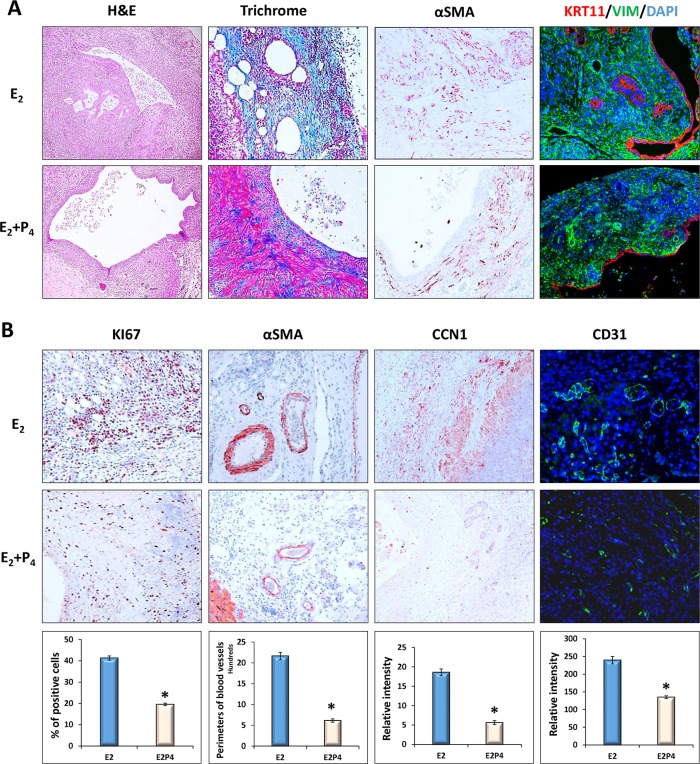
P4 inhibits E2-dependent cell proliferation and angiogenesis in ectopic lesions.Sections of the ectopic lesions collected from E2 or E2 plus P4-treated recipients (D16, n = 6) were subjected to histological examination. (A) Representative images (20X) showing H&E and Trichrome staining, or IHC analysis using antibody against myofibroblast biomarker αSMA, uterine epithelial biomarker KRT11, or uterine stromal biomarker VIM, respectively. (B) Representative images (20X) showing IHC analysis using antibodies against cell proliferation biomarker KI67, smooth muscle biomarker αSMA, endothelial cells CD31, or an angiogenetic regulator CCN1, respectively. The numbers of KI67-positive cells, the perimeters of the supporting blood vessels, and the immunostaining intensities of CCN1 and CD31 were analyzed by ImageJ software. The numerical values were analyzed by One-way ANOVA followed by Dunnett’s post hoc test and expressed as mean ± SEM. Statistical significance is defined as #: p < 0.05, *: p<0.01.